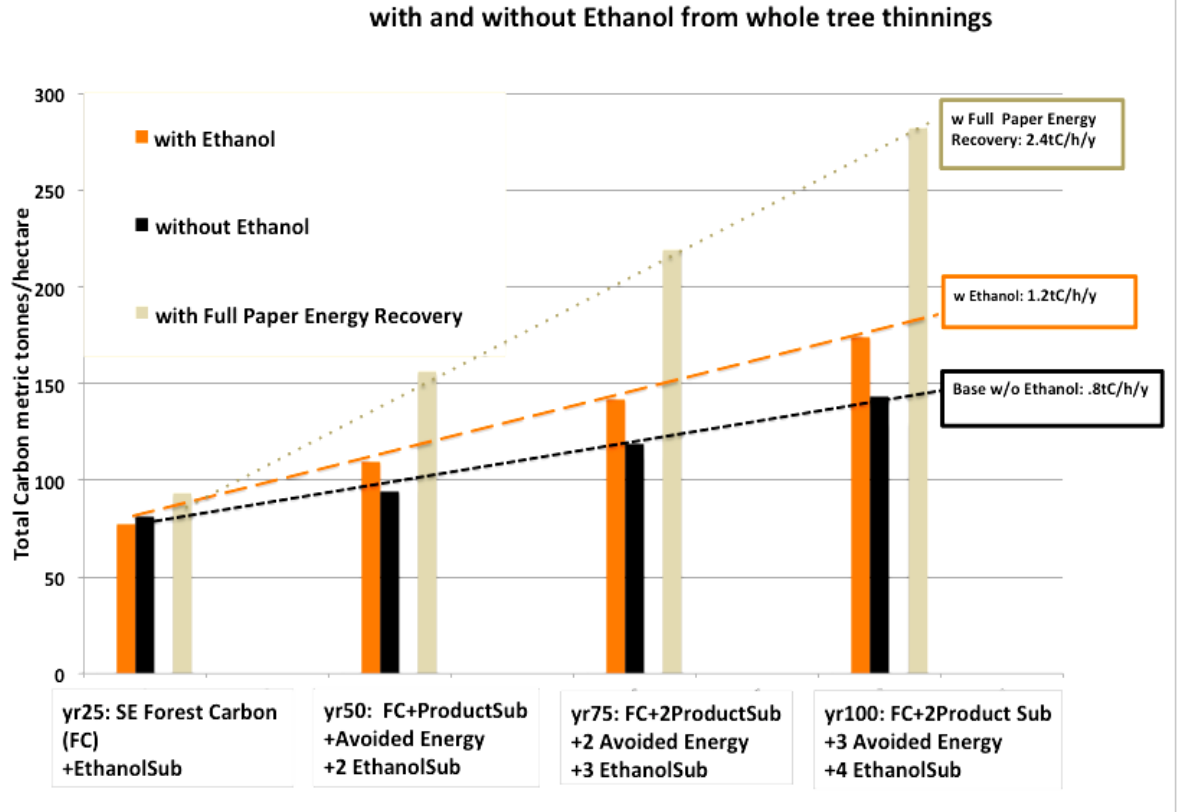
Figure 3. Sustainable carbon mitigation trend from a SE Forest: ( 1 ) Base production of construction and paper products, ( 2 ) with ethanol production from pre-commercial thinnings, and ( 3 ) with full energy recovery from the